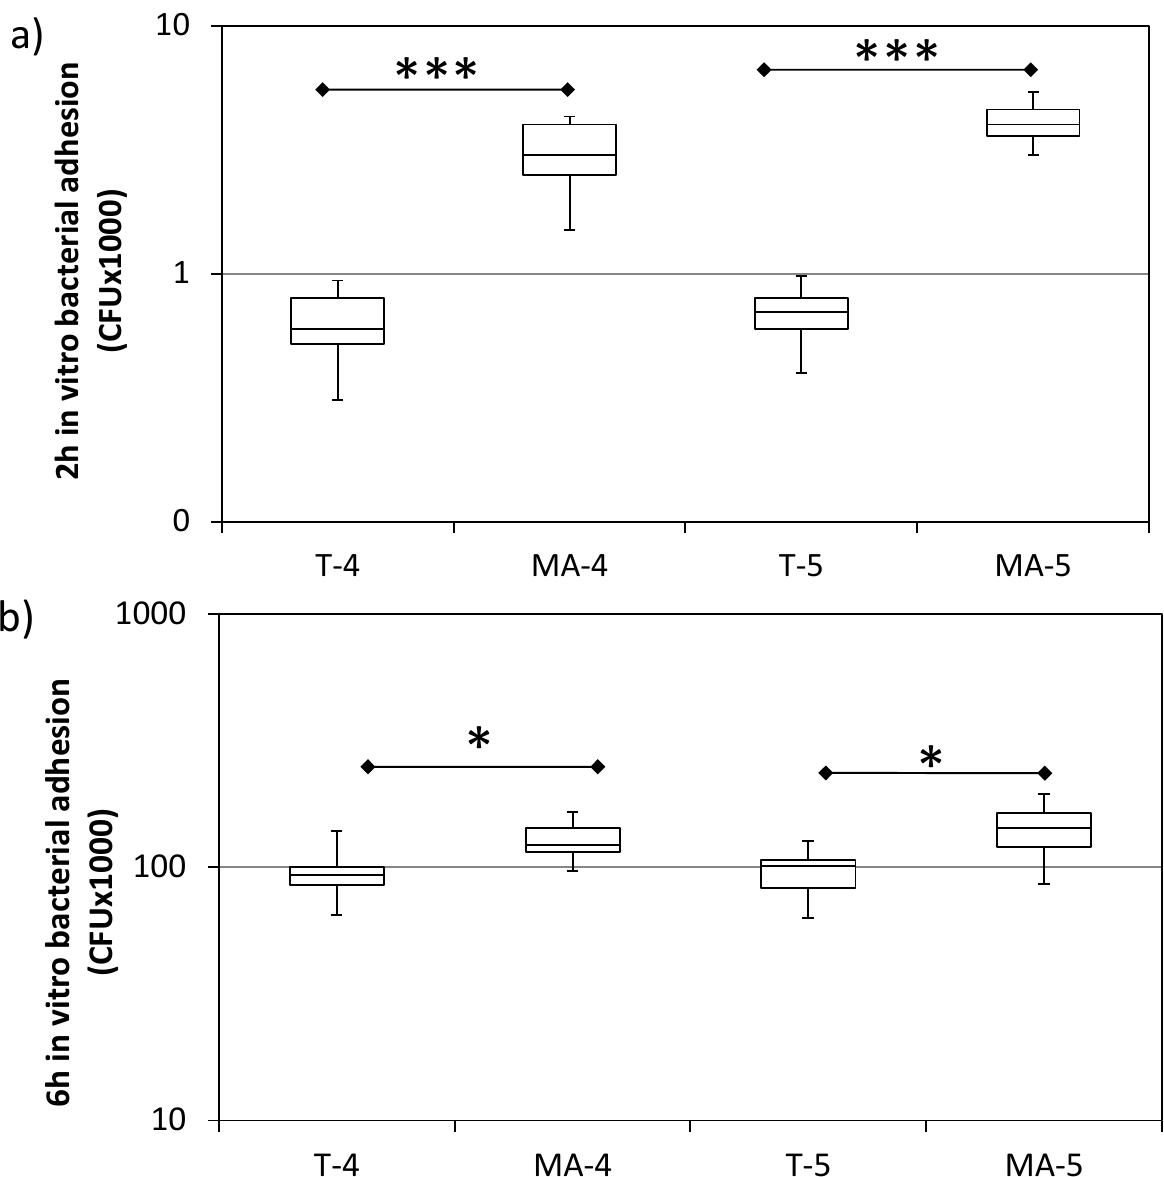
Figure 4. In vitro bacterial adhesion ( S. sanguinis ) on turned grade 4 (T-4), turned grade 5 (T-5), mildly acid-etched grade 4 (MA-4), and mildly acid-etched grade 5 (MA-5) Ti surfaces at 2 h ( a ) and 6 h ( b ) after inoculation. Data are expressed as counts of colony forming units (CFU) on a logarithmic scale (median, interquartile range, minimum/maximum). N = 9. * = p < 0.05; *** = p < 0.001.